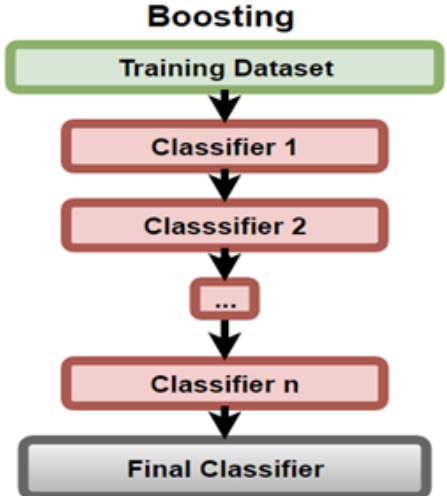
Figure 12. Boosting Diagram.